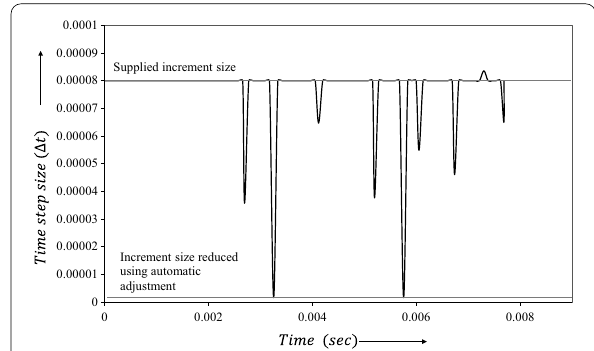
Fig. 21 History of time-step size for LCP continuous mass frame.